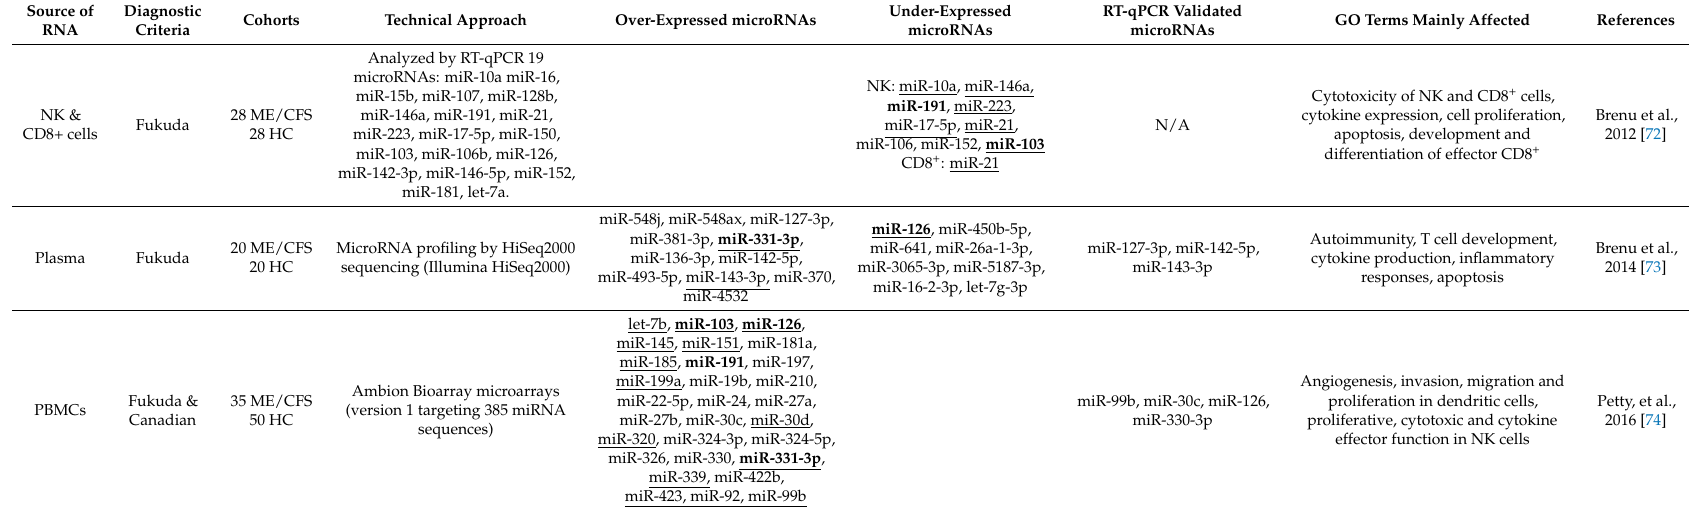
Table 2. Summary of studies evaluating ME/CFS miRNomes by multiplex